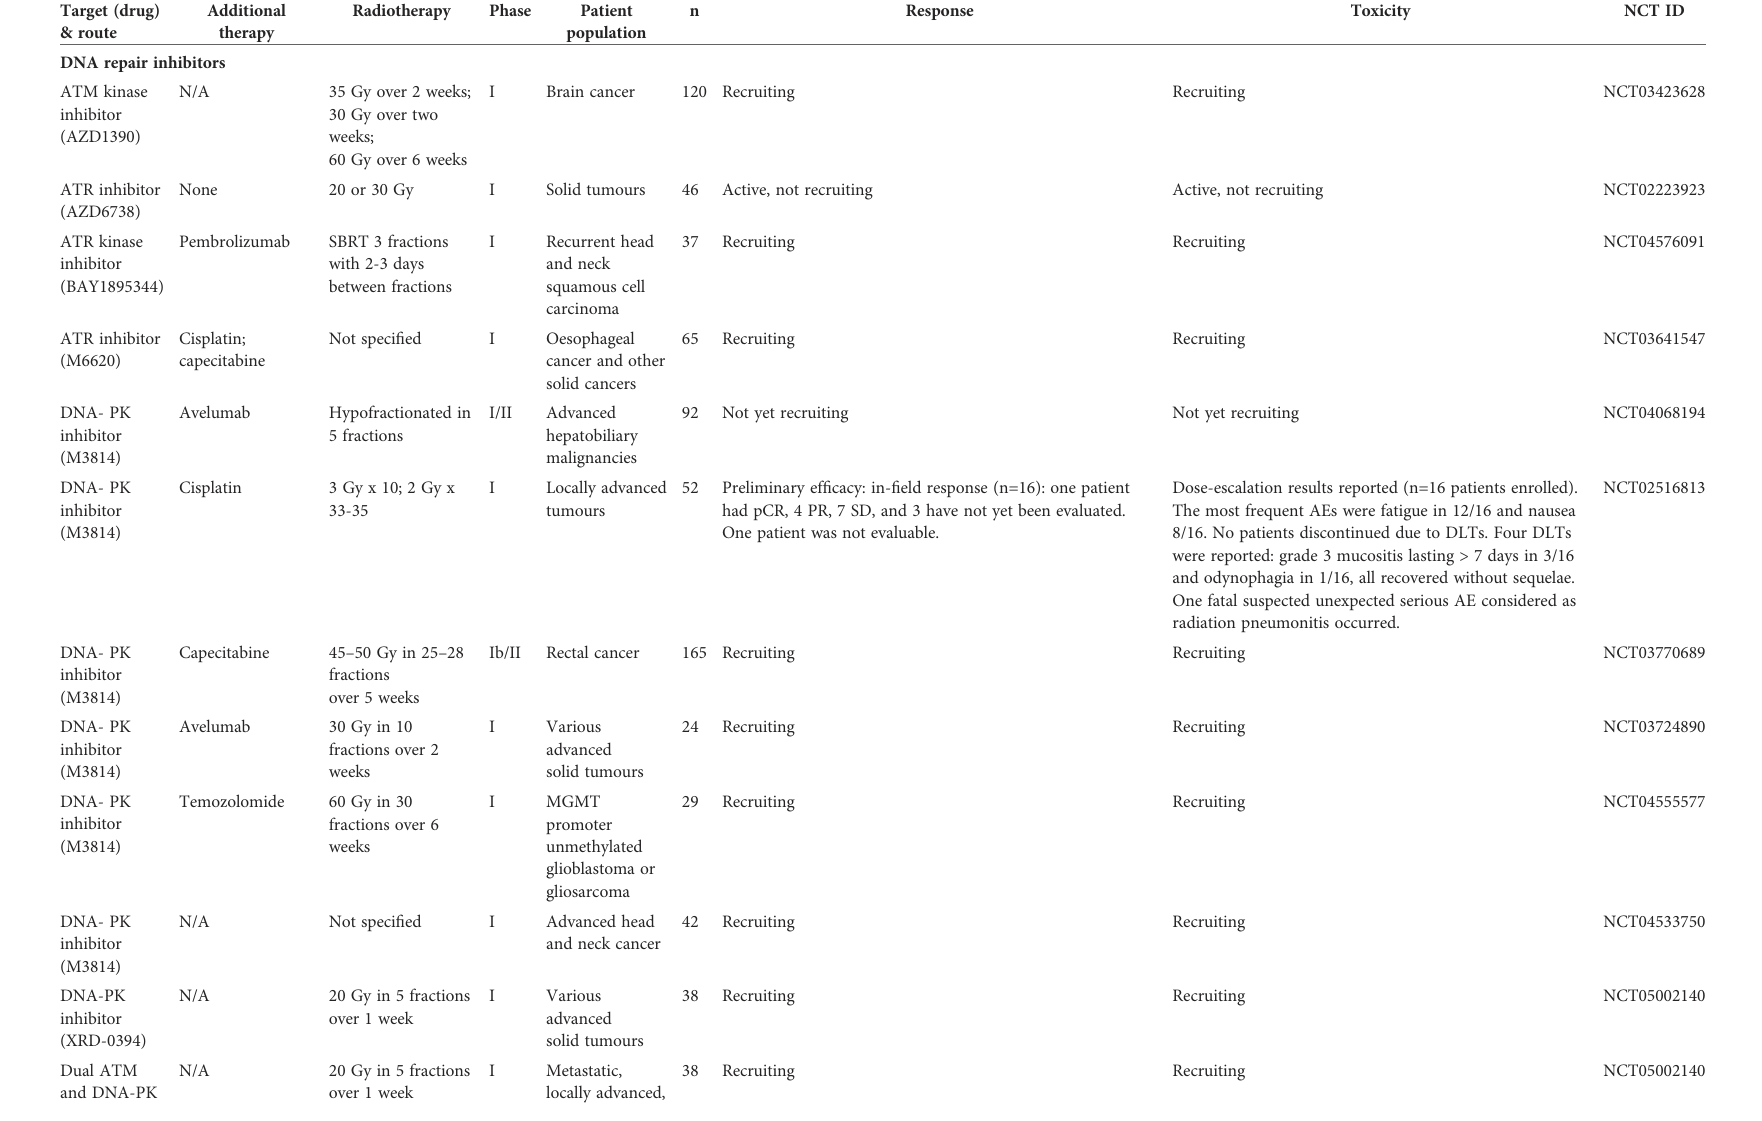
TABLE 2 Selected clinical trials investigating radiotherapy in combination with DDR inhibitor and/or other agents. Target (drug) &